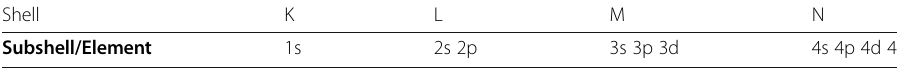
Table 2 Designation of electron configurations of atom Shell